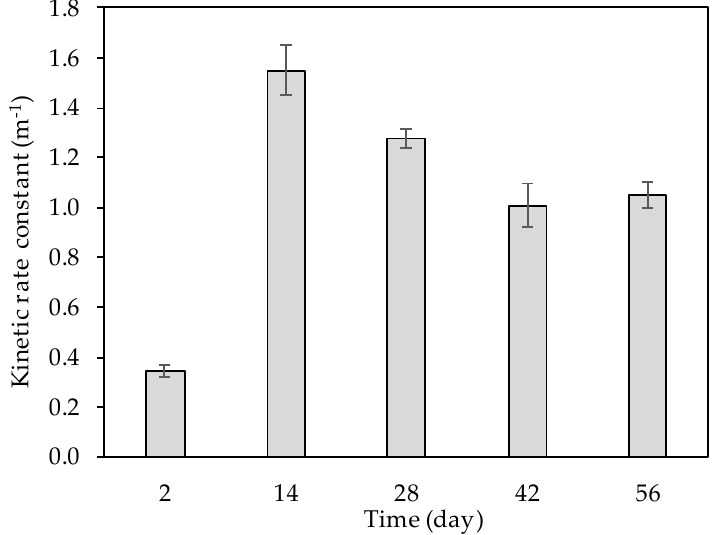
Figure 5. First-order kinetic constant ( k 1 ) for the decrease in NH 4 + -N concentration along the single axis of the dropping nitrification reactor over 56 days of operation. Values are means ± SD ( n = 4).